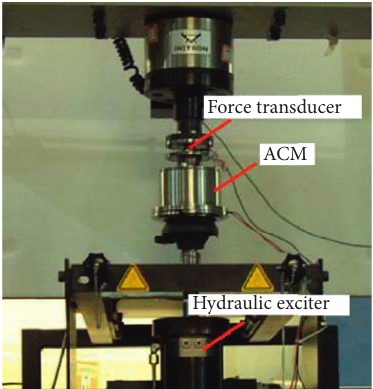
Figure 8: Harmonic identification tests [100].